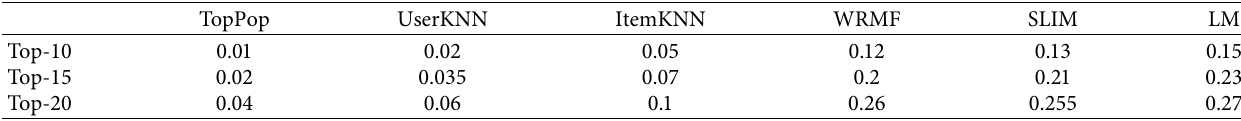
Table 7: Comparison of HR indicators on datasets.